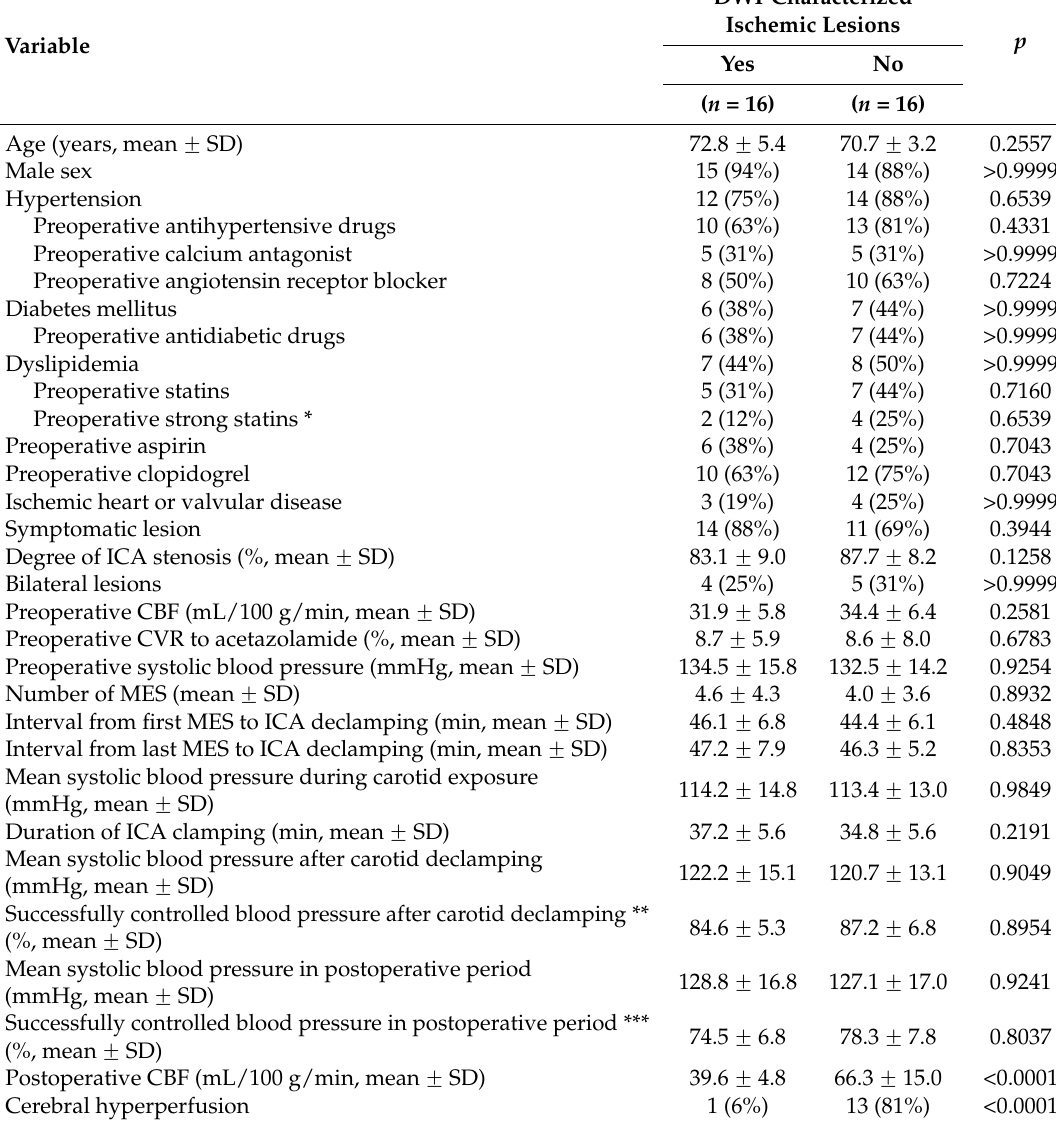
Table 1. Univariate analysis of factors related to development of diffusion-weighted imaging (DWI)-characterized postoperative cerebral ischemic